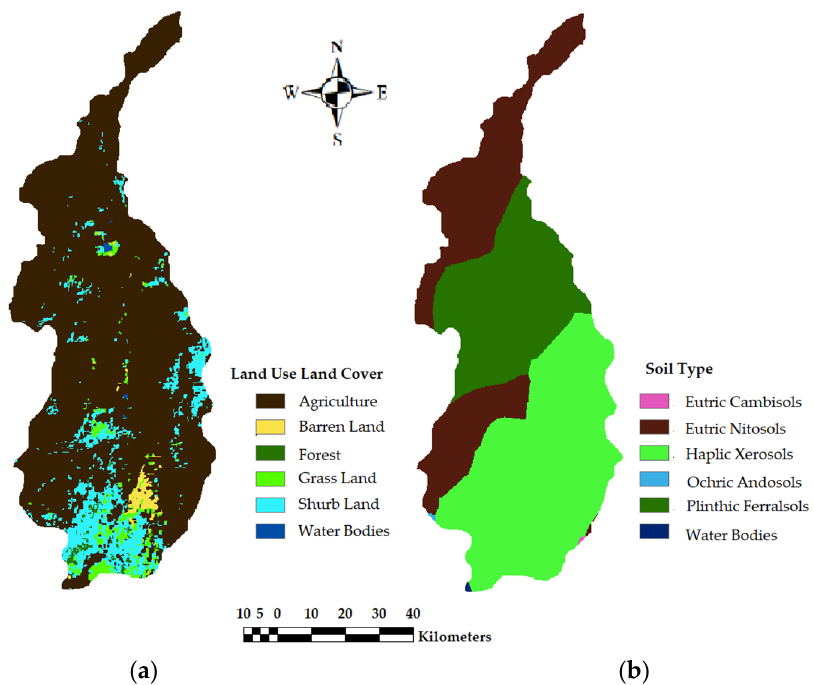
Figure 2. ( a ) Major land-use types derived from harmonized FAO 98 database [64] land use classification; and ( b ) major soil types in the Bilate Watershed.